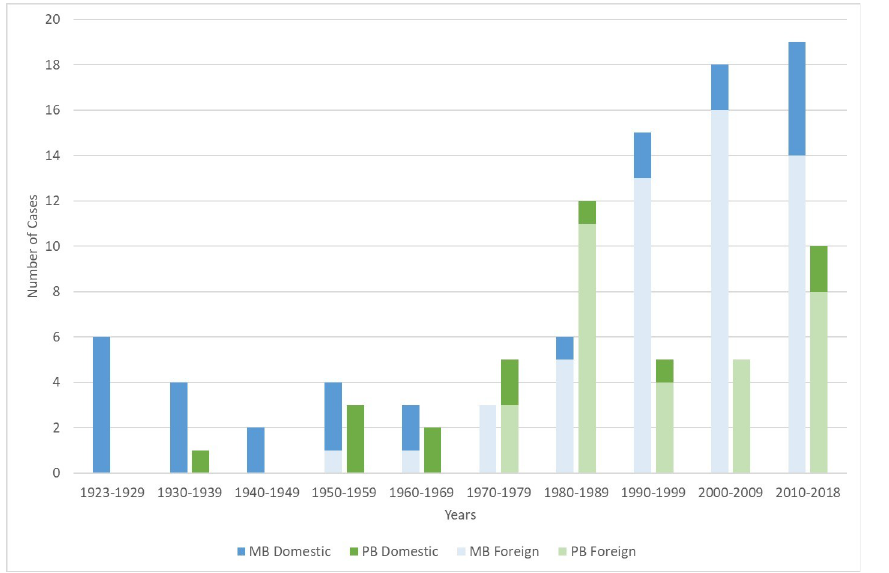
Fig 1. Number of leprosy cases in Georgia from 1923–2018 by birth location and leprosy type.